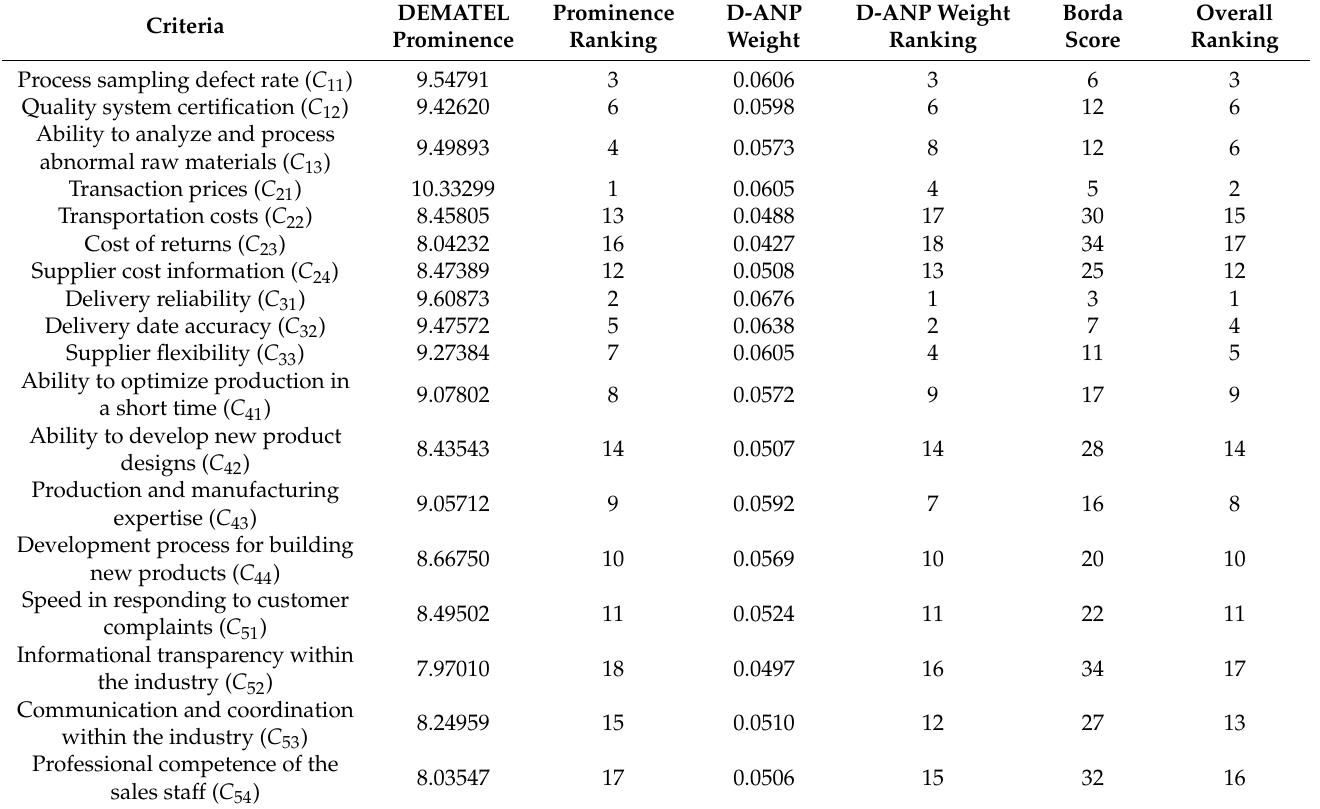
Table 11. Overall ranking of criteria for supplier